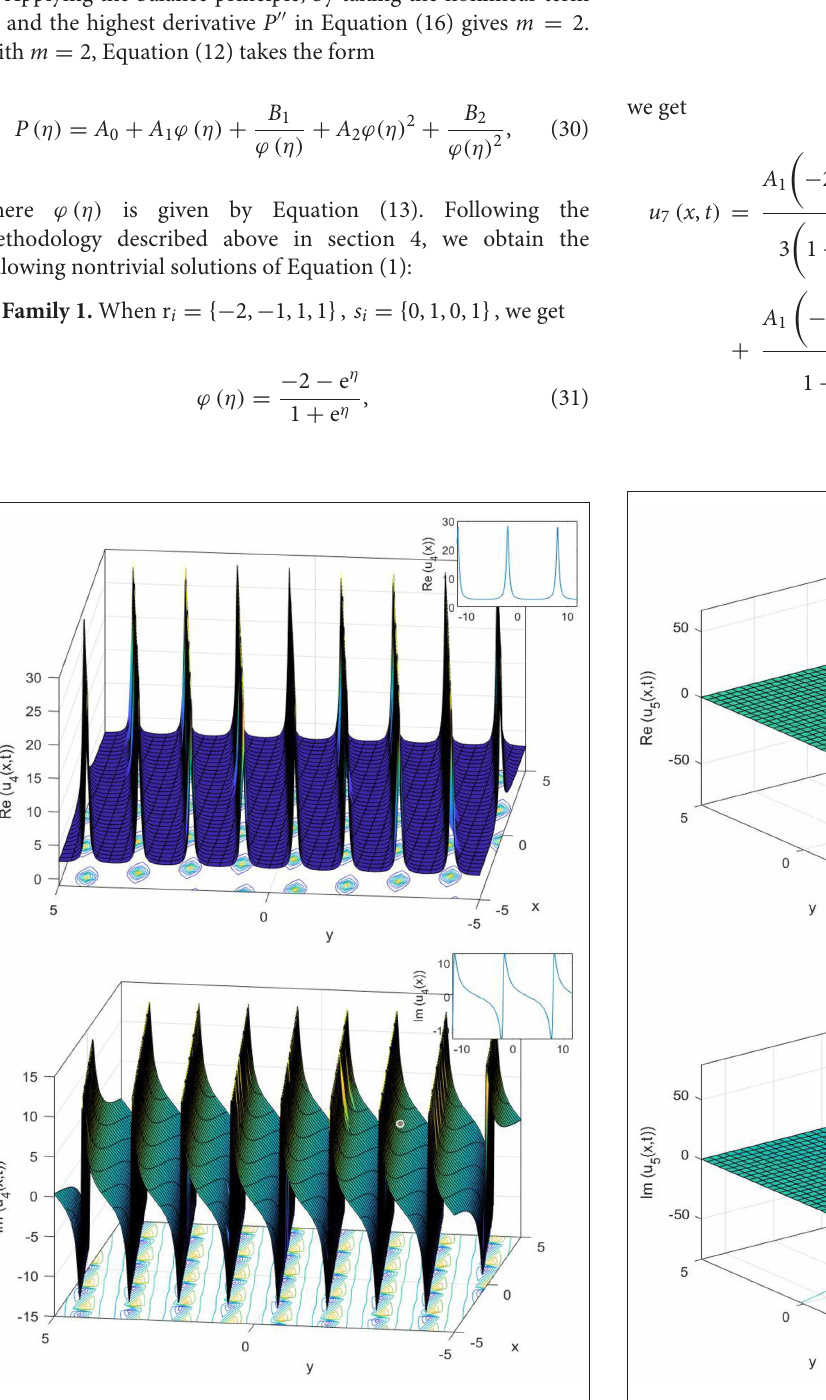
FIGURE 4 | The 3D, 2D, and contour surfaces of Equation (25), using k 4.5, α 0.4, ǫ 0.3, C 1 0.2, and a 1 = = = =